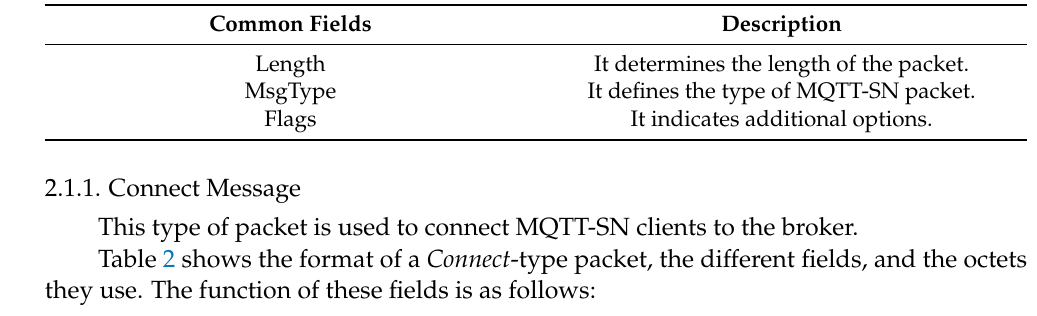
Table 1. Brief description of the fields common to the different